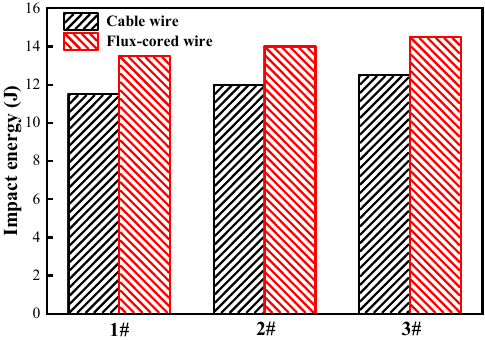
Figure 15. Charpy impact energy comparison histogram of flux-cored wire and cable wire welding joints.